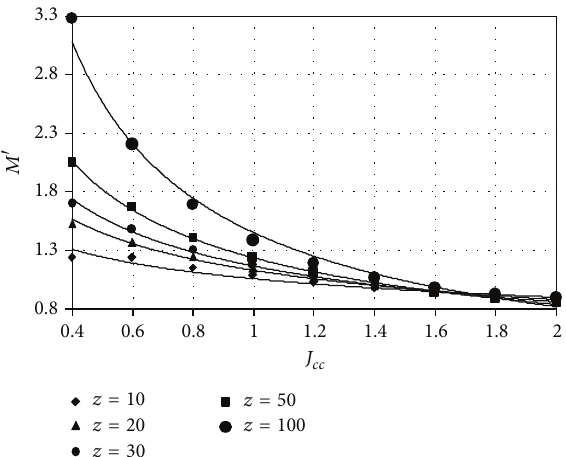
Figure 2: Correction function 𝑀 󸀠 versus cooling rate lag factor at thecoldestpoint 𝐽 𝑐𝑐 andversus 𝑧 ( ∘ C)value.Thesolidlinesarepower functions obtained by nonlinear regression.